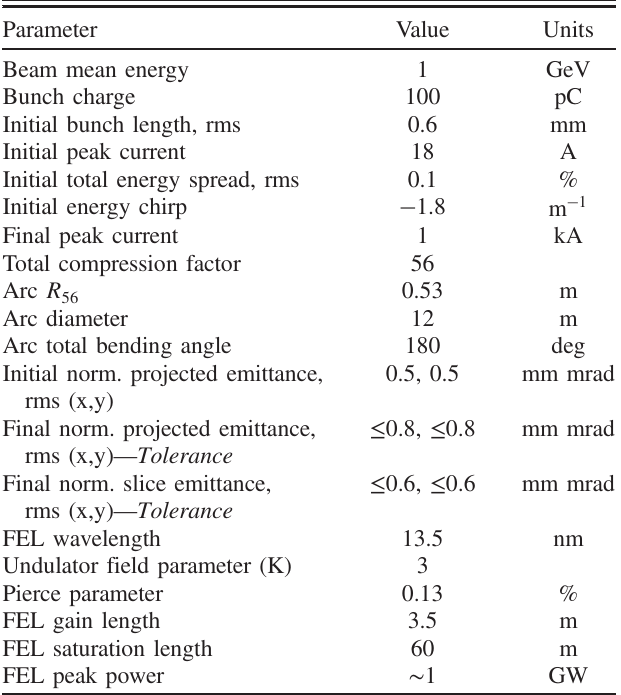
TABLE I. Electron beam, compressive arc, and SASE FEL parameters. The electron distributions in the 6D phase space are all Gaussian with 2 sigma